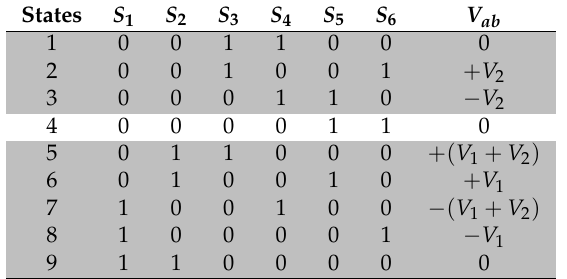
Table 1. Switching states for the basic unit. The states in light gray are used in this paper.